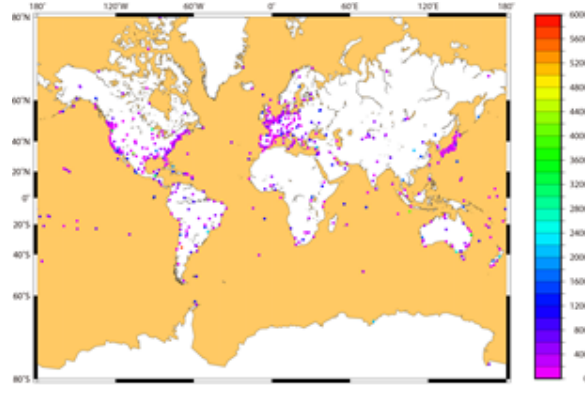
Figure 7. IGS stations - accuracy distribution